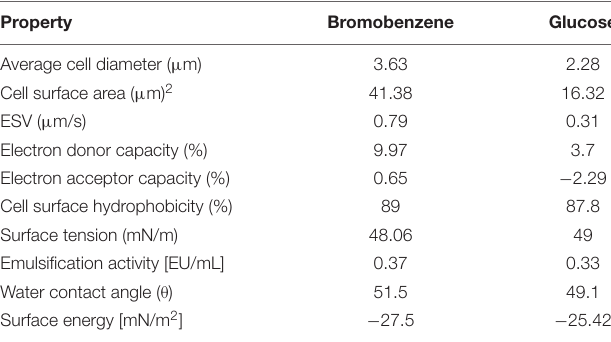
TABLE 3 | Cell surface properties of Yarrowia lipolytica NCIM 3589 when grown on bromobenzene and glucose a